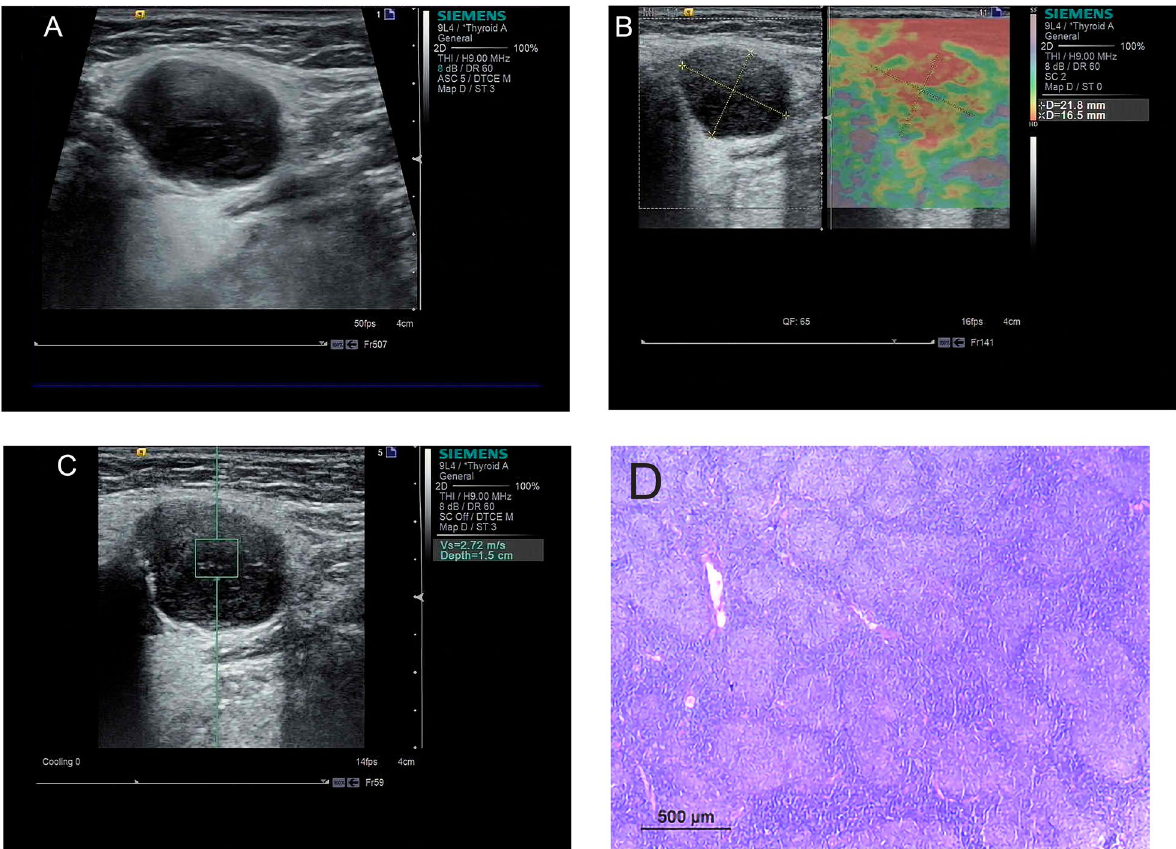
Fig. 6 Hodgkin ‘s Lymphoma, erroneously diagnosed as benign by SE and correctly diagnosed as malignant by ARFI. A Grayscale US image of cervical lymph node with homogenously hypoechoic texture reticulation; absent echogenic hilum. B SE image showed total red area 10–50%